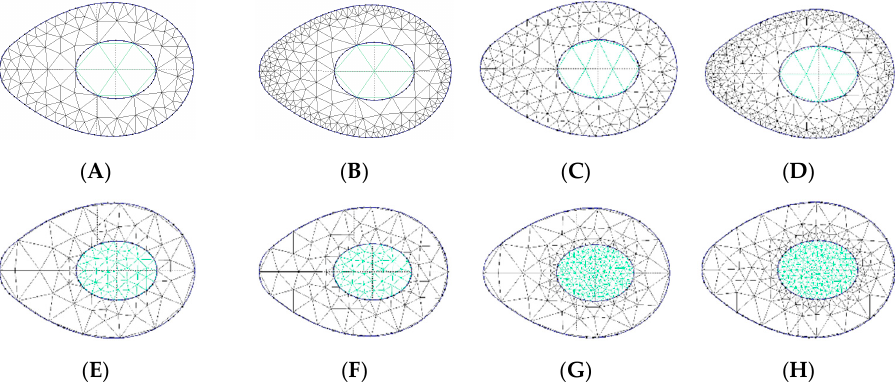
Figure 9. Heel zone inserts printed with different graded mesh densities: inserts ( A )–( D ) with bigger cell size (lower mesh density) in the middle and smaller cell size (higher mesh density) in the periphery; inserts ( E )–( H ) with the reverse mesh density distribution.